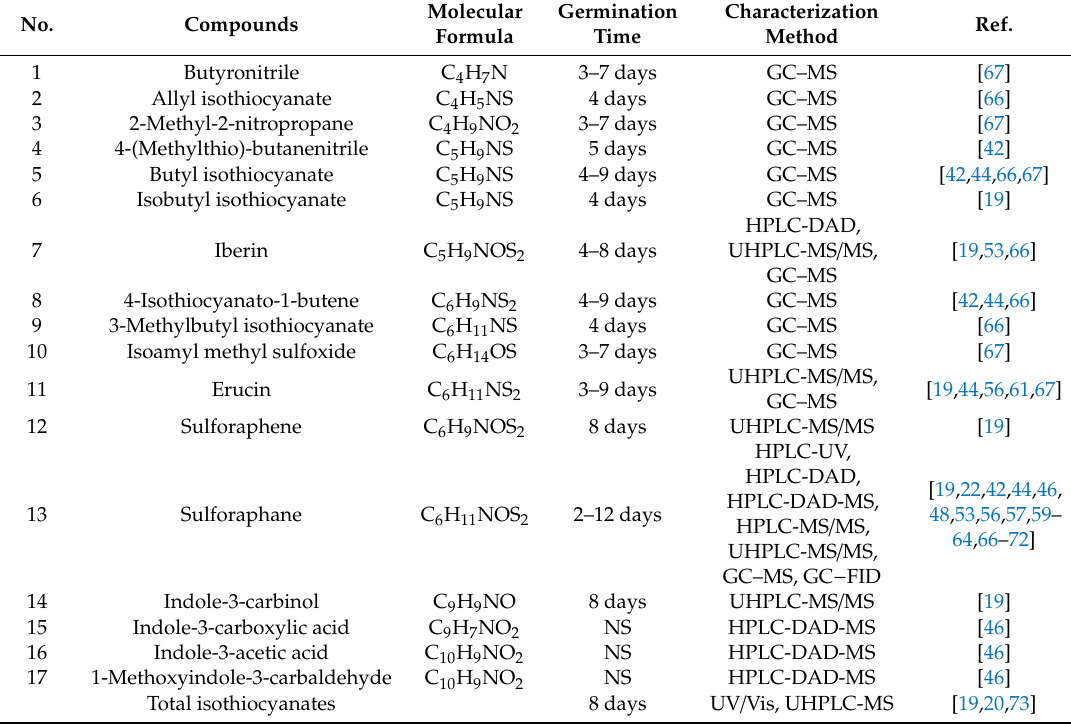
Table 2. Analysis of isothiocyanates in broccoli sprouts and